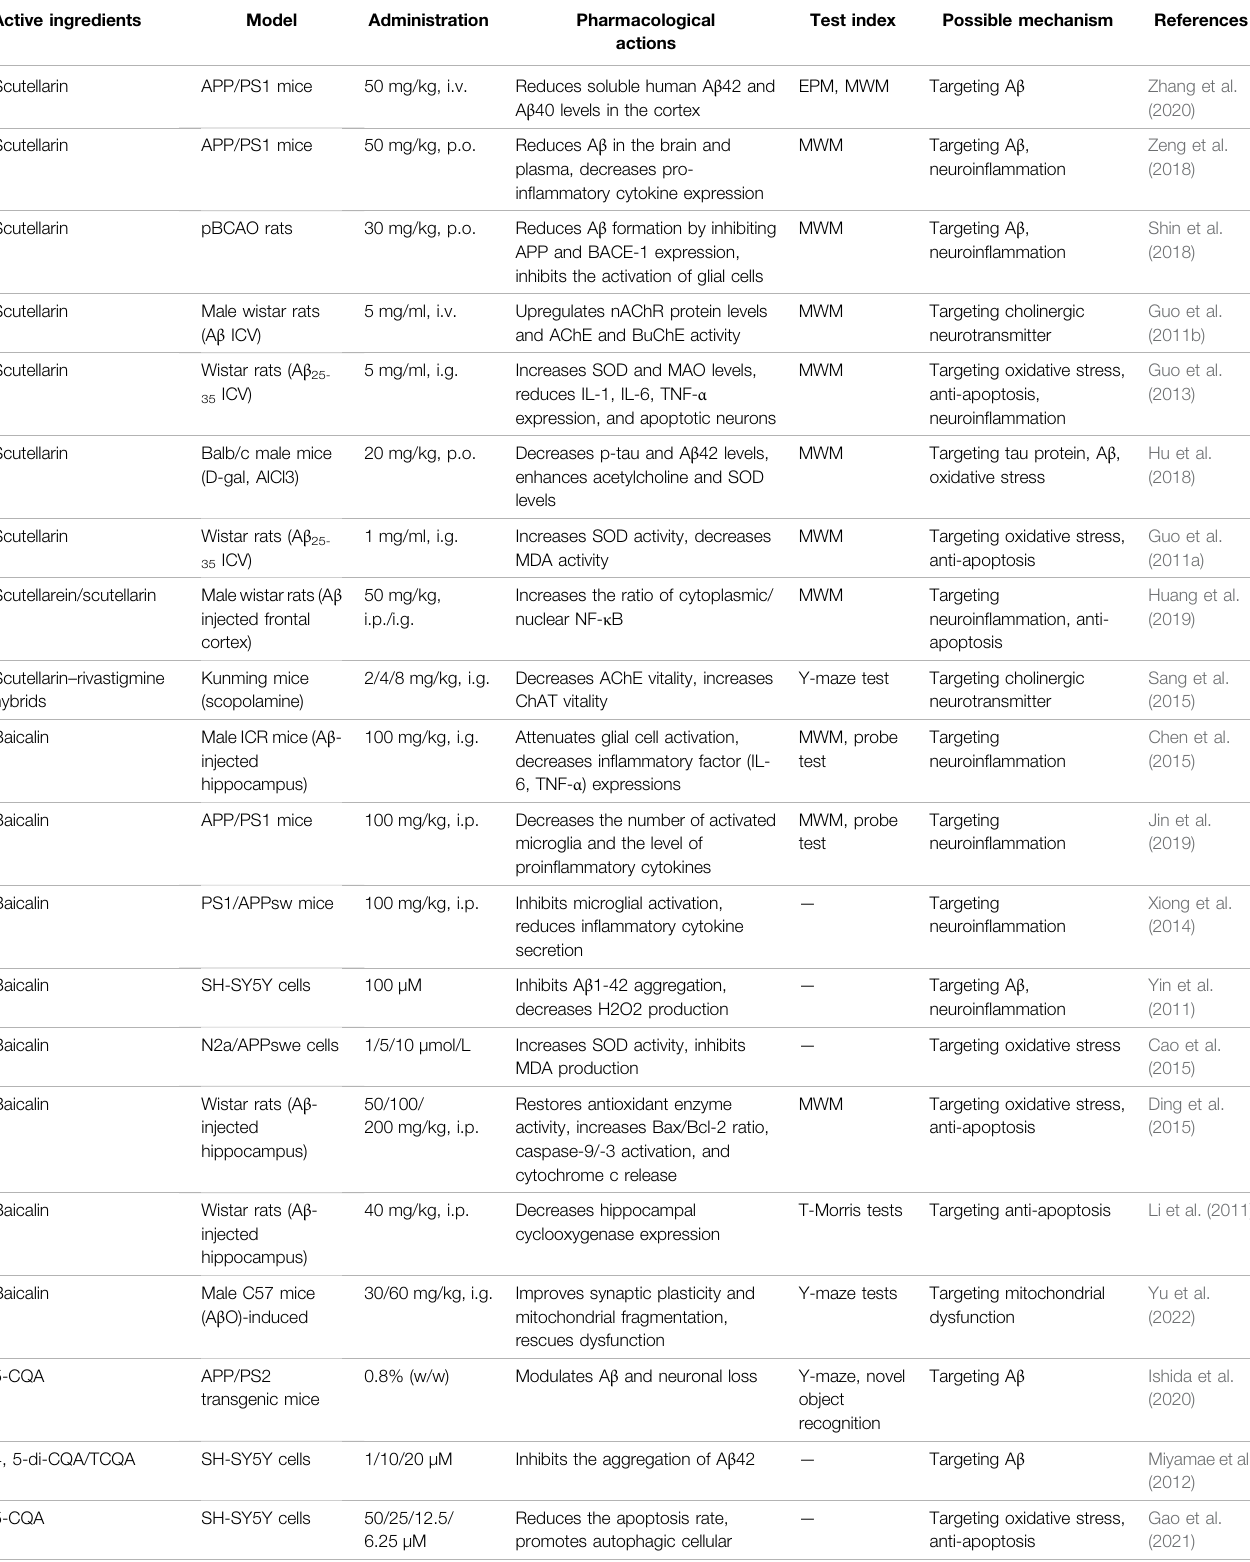
TABLE 2 | The pharmacology and possible mechanisms of compounds and metabolites in E. breviscapus (Vant.) Hand-Mazz. for Alzheimer ’ s